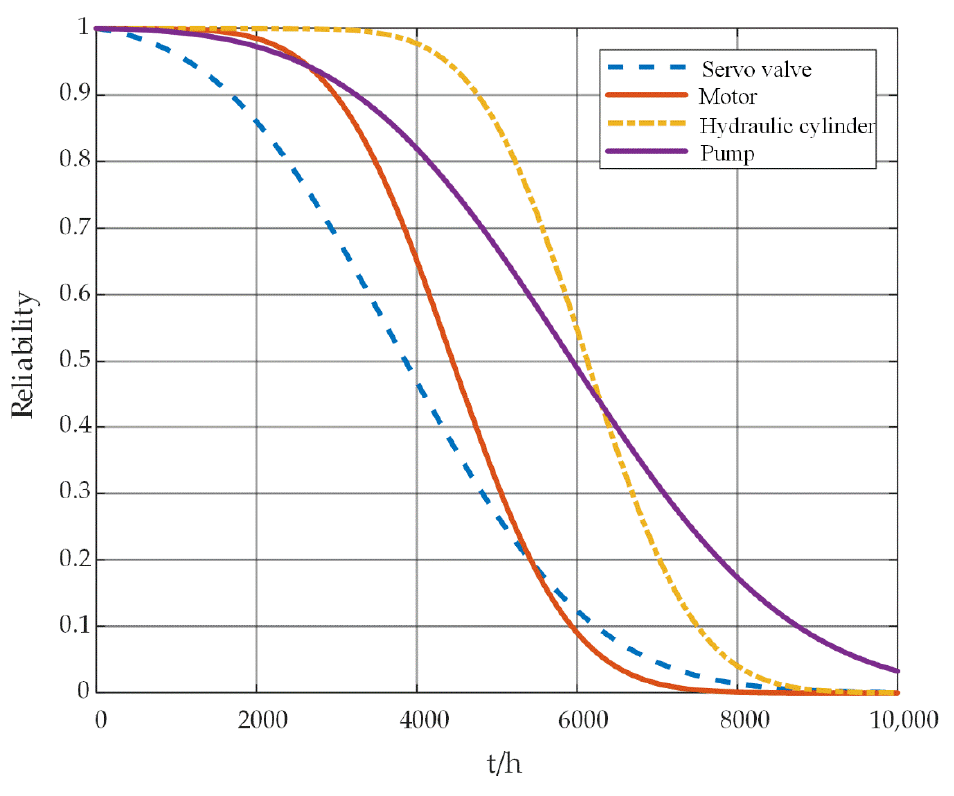
Figure 3. Reliability changes over time.